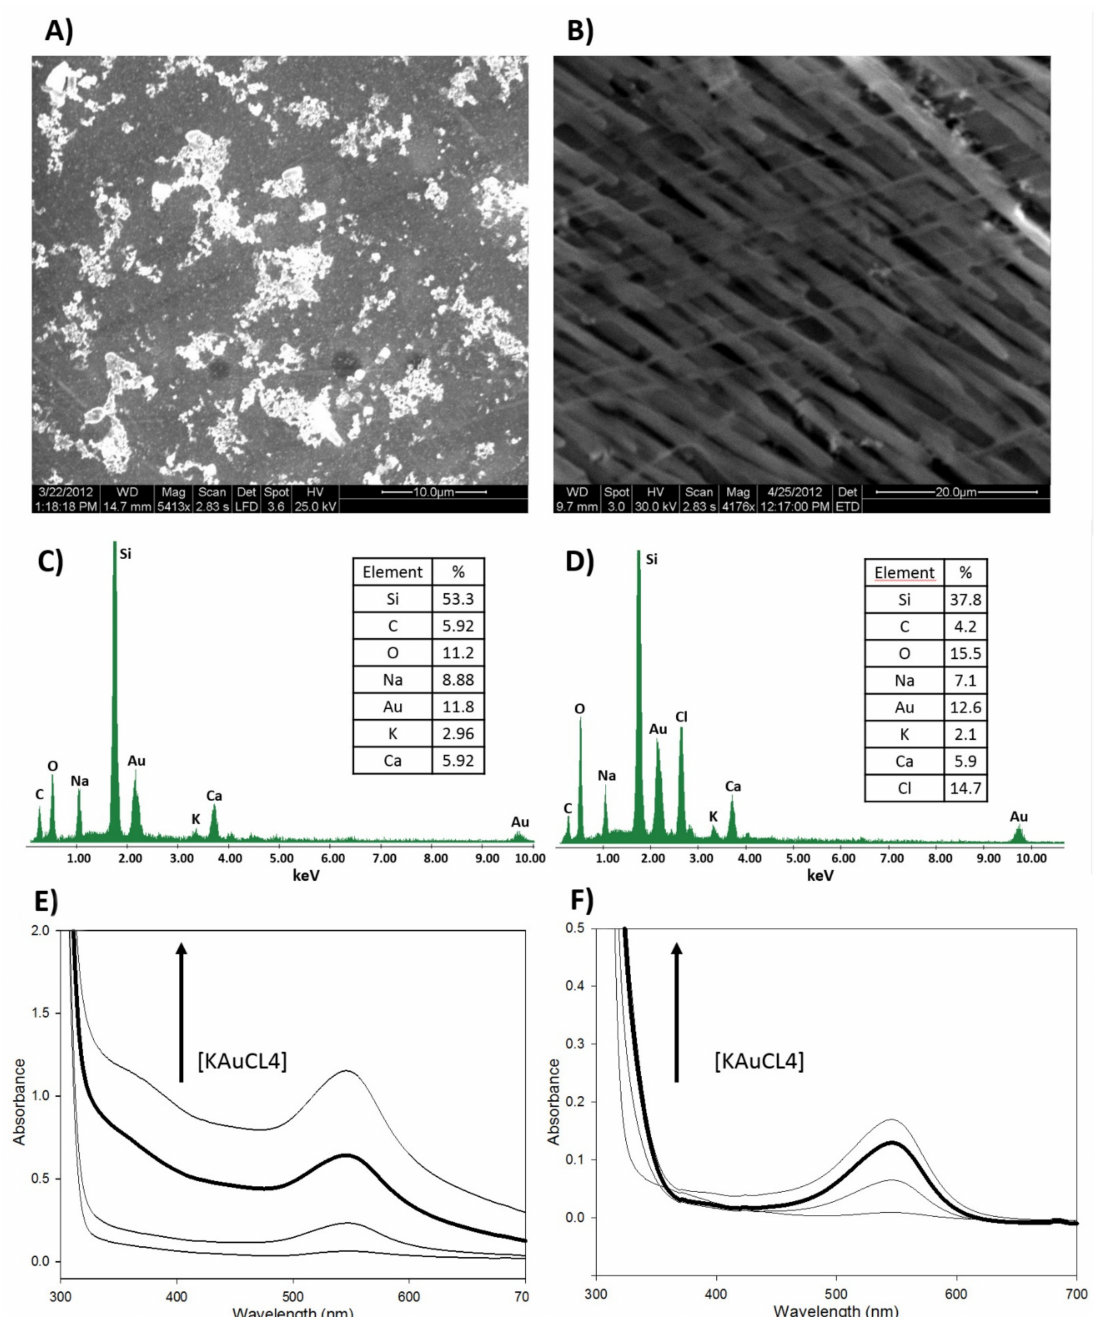
Figure 1. Comparison of the PANI-AuNPs nanocomposites obtained without dopant ( left ) and using LiClO 4 0.05 M as dopant ( right ). SEM micrographs: ( A ) without dopant; ( B ) using LiClO 4 0.05 M as dopant. EDS analysis of PANI- AuNPs nanocomposite obtained: ( C ) without dopant; ( D ) using LiClO 4 0.05 M as dopant. UV-Vis spectra of PANI-AuNPs nanocomposite obtained: ( E ) without dopant; ( F ) using LiClO 4 0.05 M as dopant, at different concentration values of the metal salt (0.1, 0.25, 0.5 and 1 mM KAuCl 4